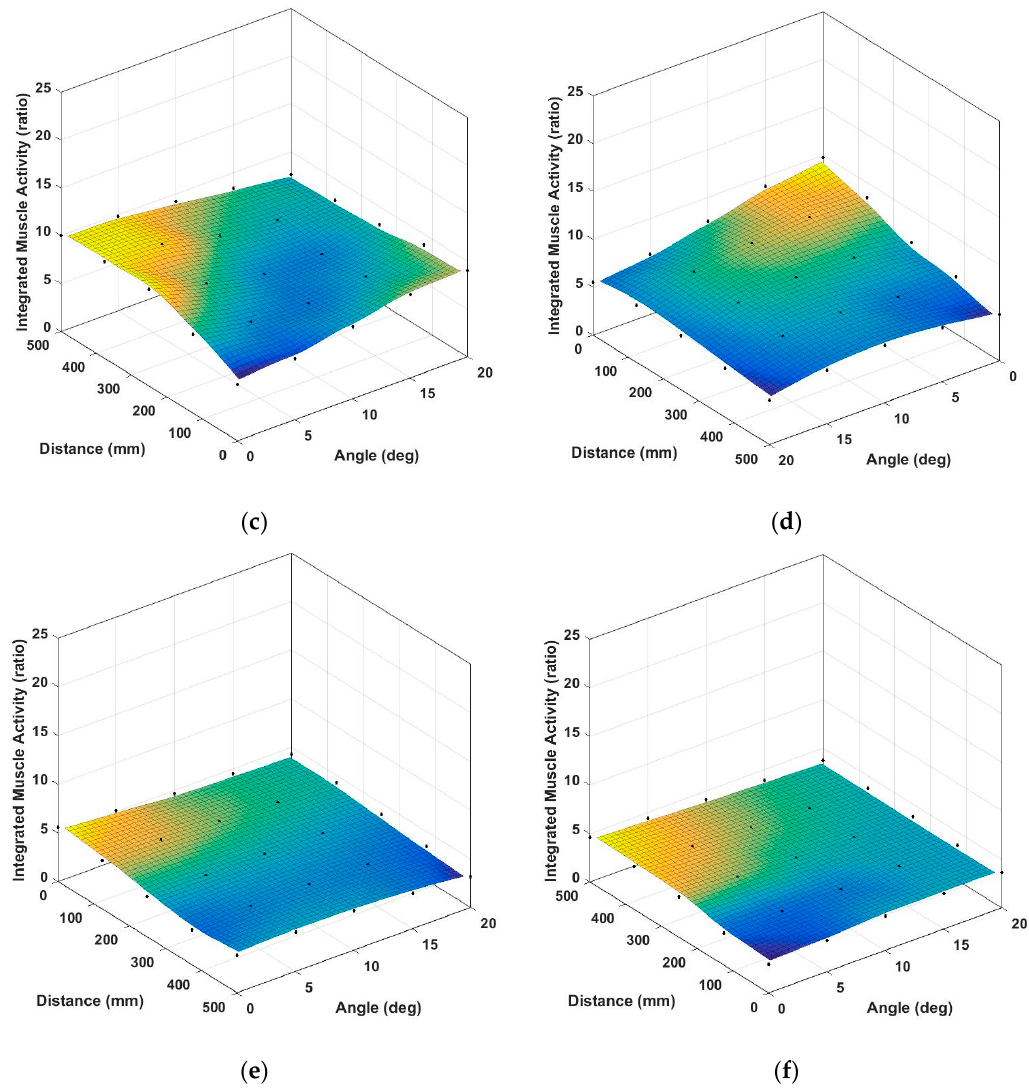
Figure 12. Average muscle activities of right leg simulated for synthesized motions (units: no unit): ( a ) rectus femoris; ( b ) vastus lateralis; ( c ) vastus medialis; ( d ) semitendinosus; ( e ) adductor longus; ( f ) gluteus maximus.